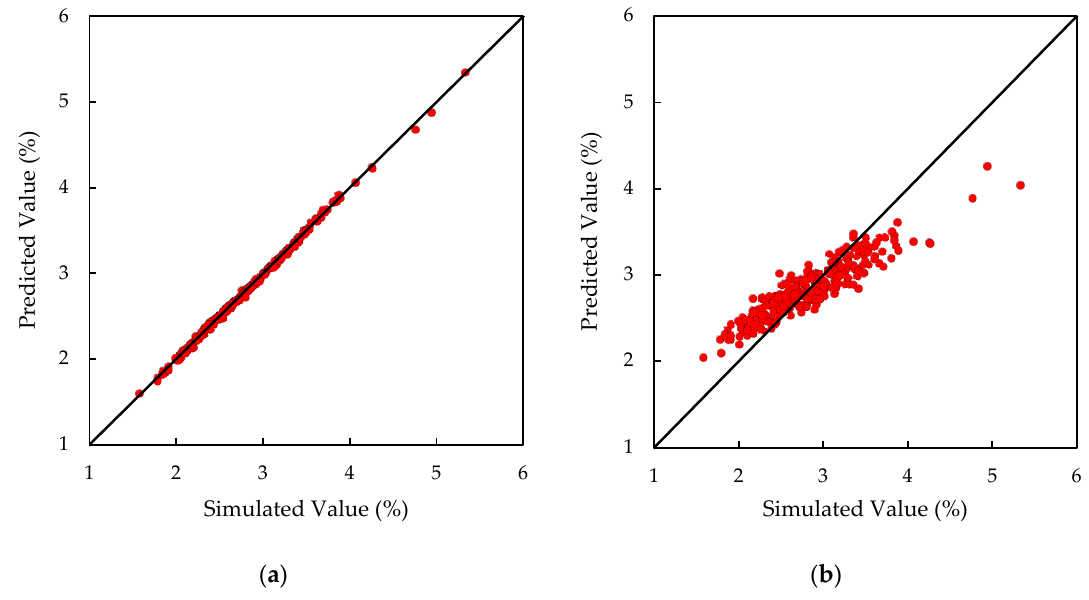
Figure 2. Comparison between simulated and predicted values of maximum thinning in the U-Channel case with the DC06 material by the algorithms: ( a ) MLP; ( b ) kNN.